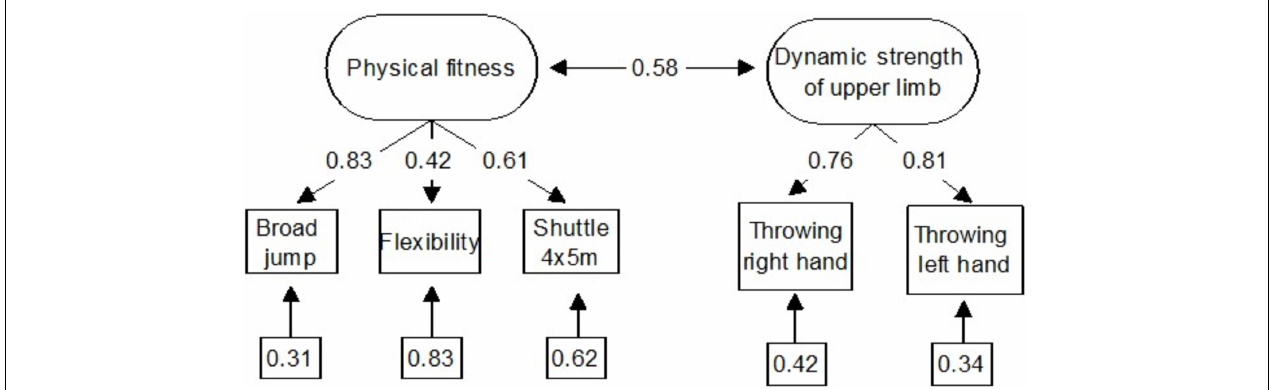
FIGURE 1 | Path diagram two-factors structure of physical fitness indicators.